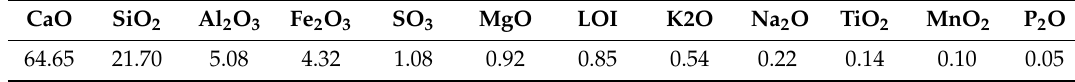
Table 1. Main chemical composition of P · II 42.5